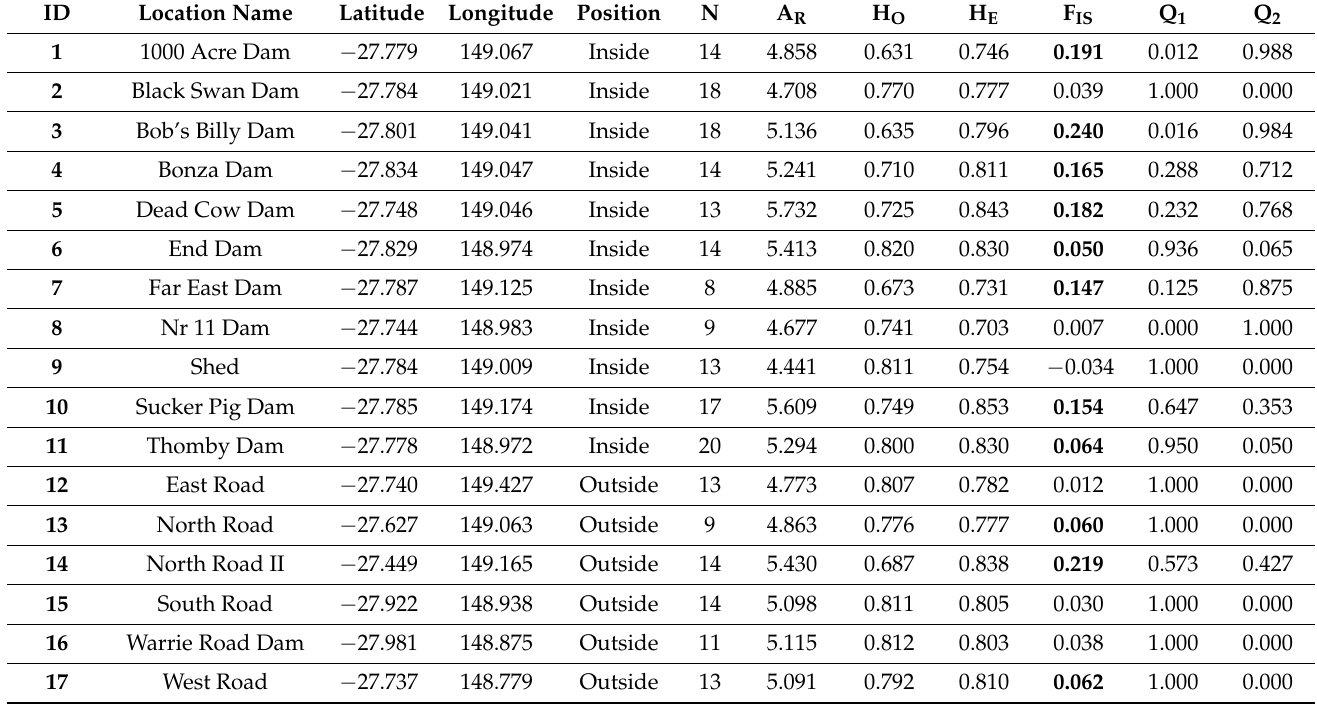
Table 1. Locations ID and names; latitude; longitude; position (inside or outside of the Mourachan Conservation Property); number of samples (N); allelic richness (A R ); observed heterozygosity (H O ); expected heterozygosity (H E ); inbreeding coefficient (F IS ; statistically significant values in bold); and S TRUCTURE Q-values assigning the population to cluster 1 (Q 1 ) or cluster 2 (Q 2 ; see Figure 1 for